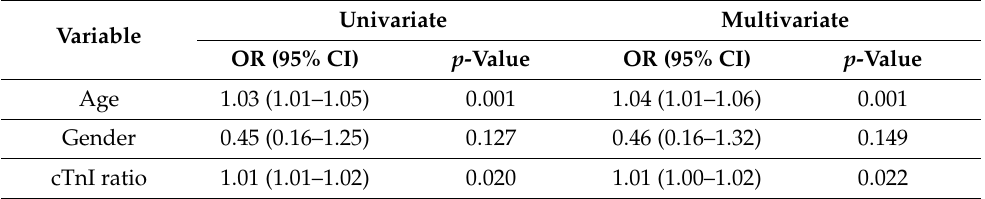
Table 4. Logistic regression for the prediction of AMI death.